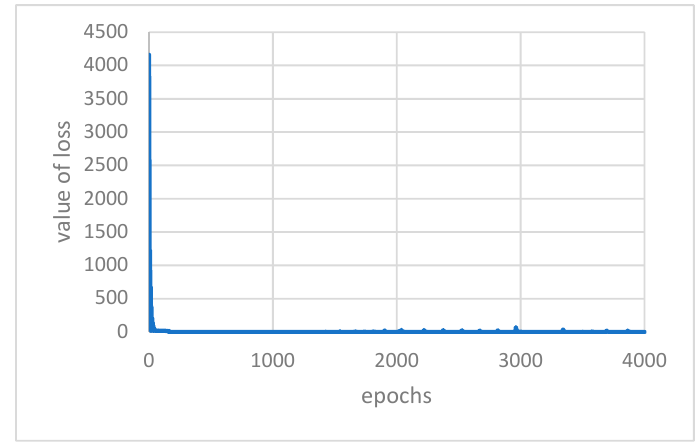
Figure 10. Value of loss with epochs in AutoEncoder.